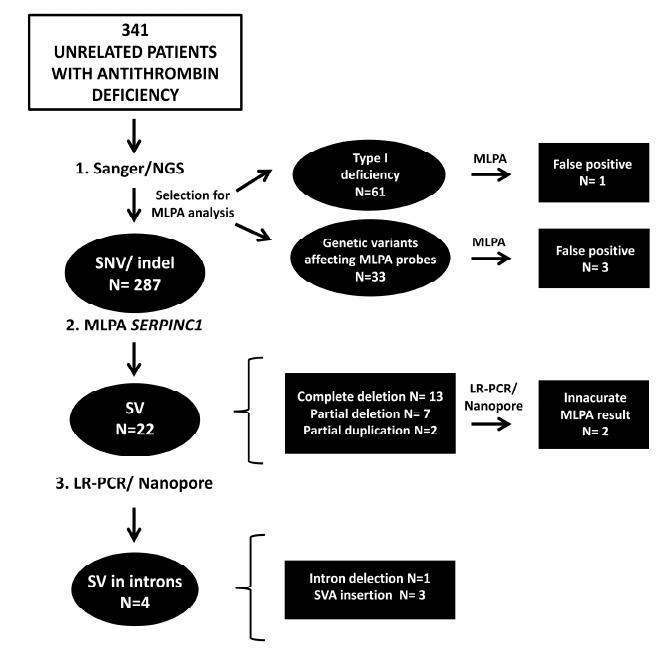
Figure 1. Genetic defects identified in our cohort of patients with confirmed antithrombin deficiency following the current diagnostic algorithm for molecular characterization of this disorder. Also shown are cases selected for screening of SVs by MLPA because they are carrying: (i) an SNV or INDEL and had a type I deficiency or (ii) a genetic variant in areas potentially sensitive to MLPA probe binding.